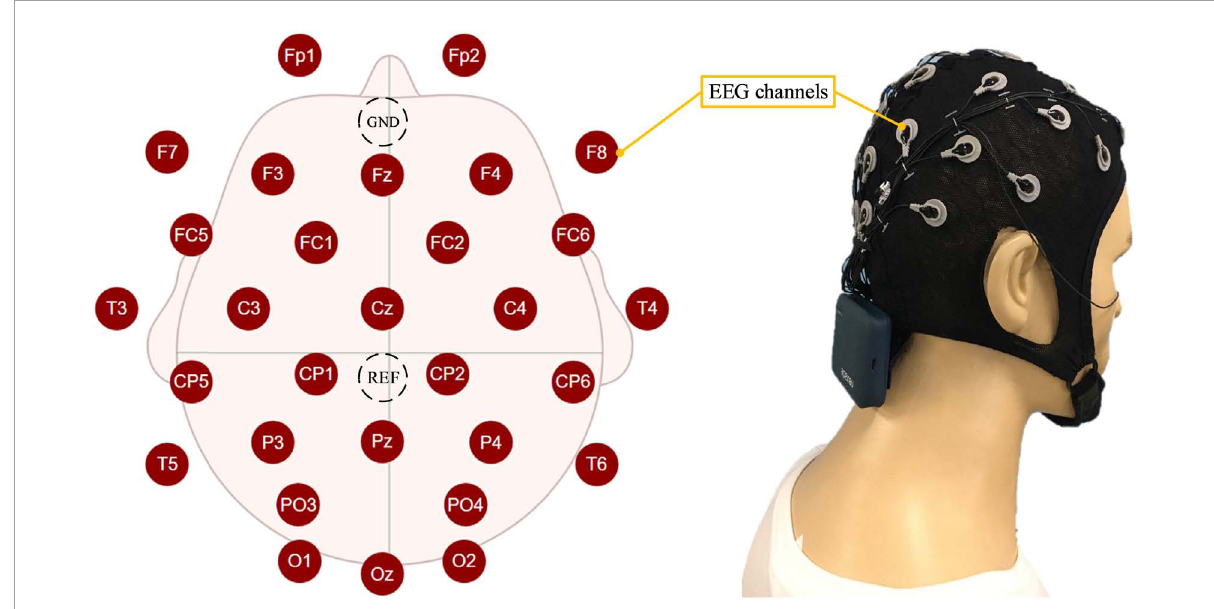
FIGURE1 The distribution of electroencephalogram (EEG) electrodes and how the participant wore them.